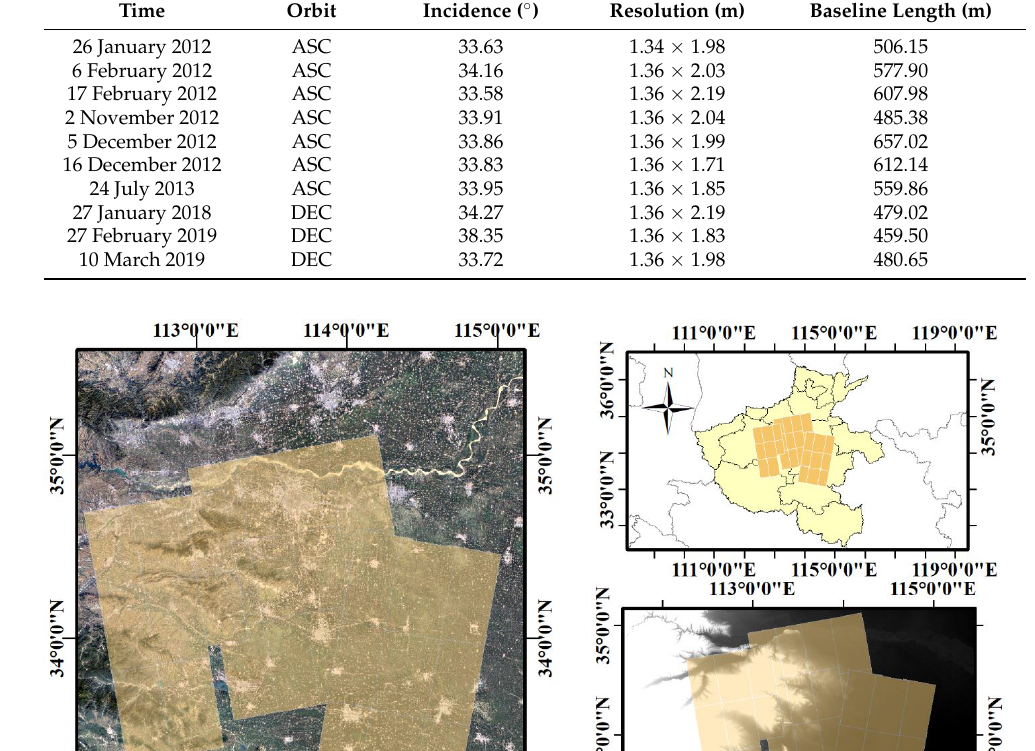
Table 2. Specific information of CoSSC data. The table is listed by track.